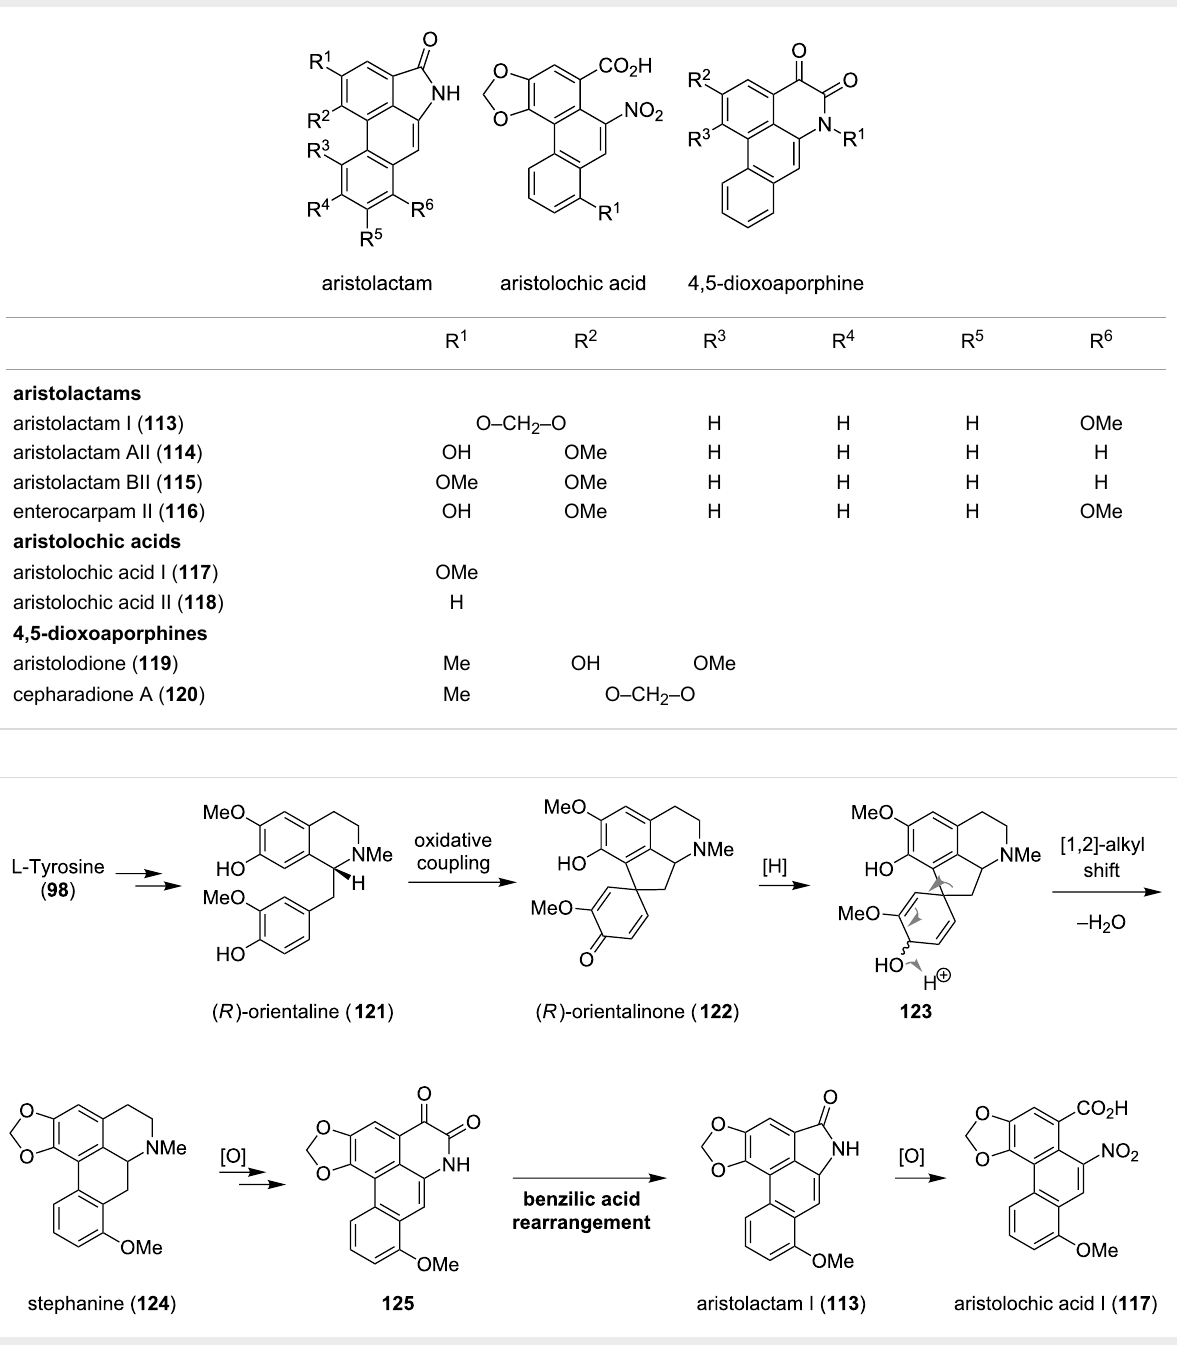
Table 1: Selected members of the aporphine alkaloid family.